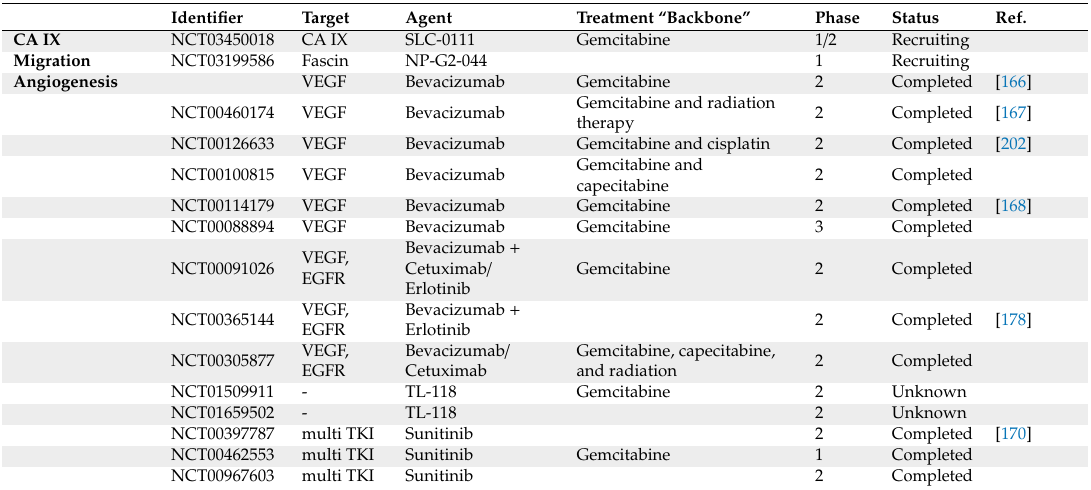
Table 1. Clinical trials for pancreatic cancer targeting molecular pathways with relationship to